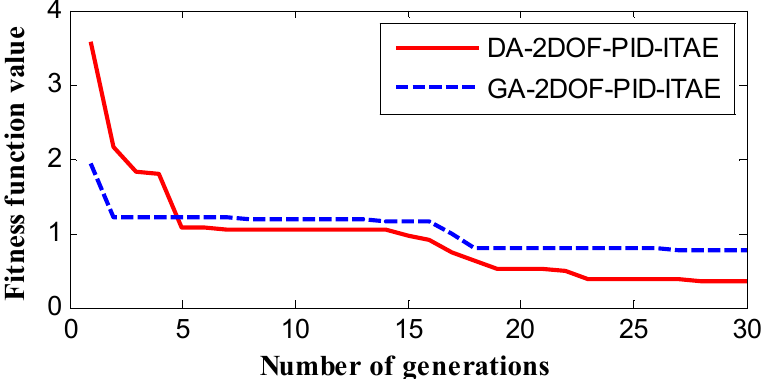
Figure 26. Δ P using GA-2DOF-PID, DA-2DOF-PID, and classical-2DOF-PID with IB-WGFF. Figure 26. ∆ P using GA-2DOF-PID, DA-2DOF-PID, and classical-2DOF-PID with IB-WGFF.